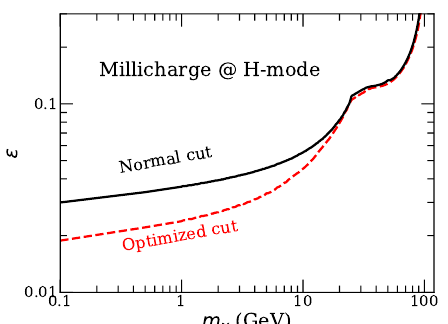
Figure 18 . Expected 95% CL upper bound on millicharge analyzed with the \optimizated" cuts, and with the cuts used previously for millicharged DM